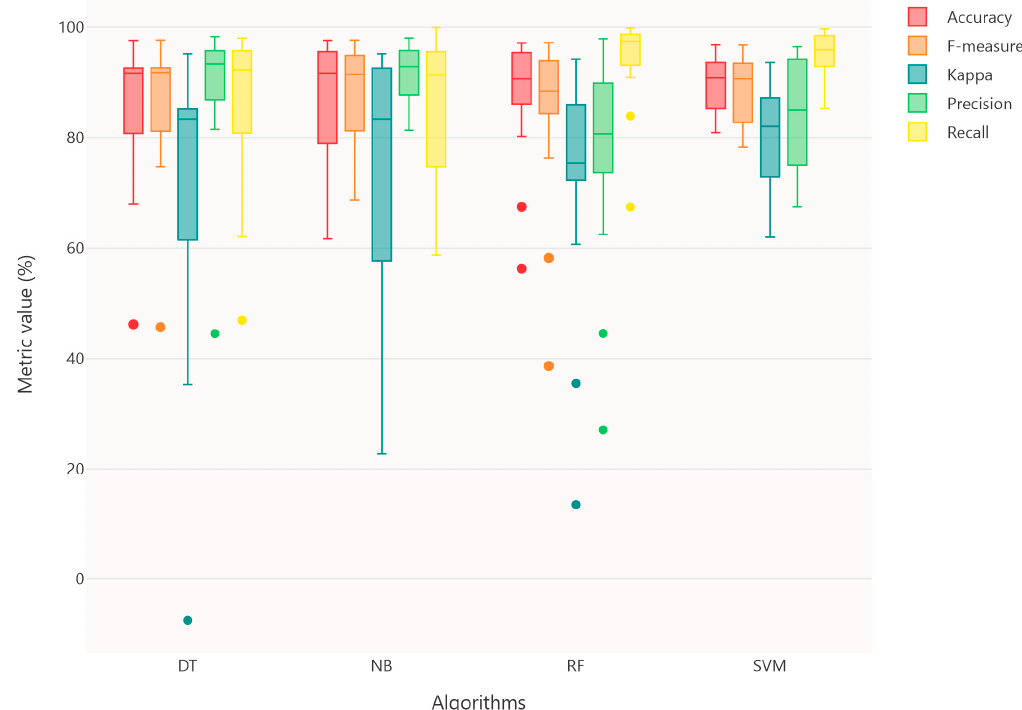
Figure 4. Box-plot representing the overall accuracies of the algorithms when considering multiple dates on its evaluation.